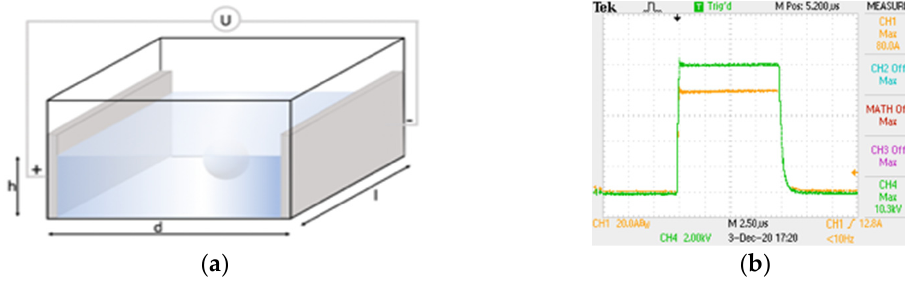
Figure 2. ( a ) Batch treatment chamber with volume V = h ∙ d ∙ l (cm 3 ), where h (cm) is the height of the mixture, d (cm) the distance of the electrodes and l (cm) the width of the chamber. The voltage U (kV/cm) is applied between the two electrodes. ( b ) Voltage and current pulse example during the experiments, (green) voltage 2 kV/div, (yellow) current 20 A/div, 2.5 µs/div.